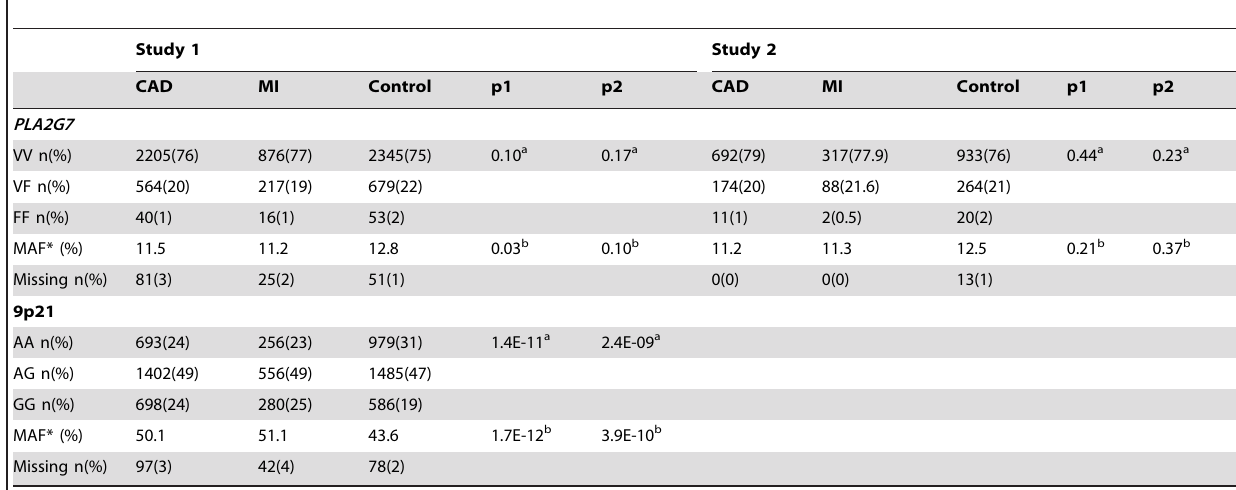
Table 2. Genotype (n, %) and allele frequencies of V279F ( PLA2G7 ) and RS10757274 (9p21) in Studies 1 and